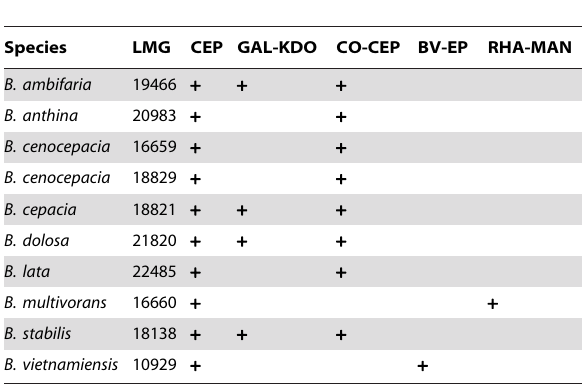
Table 5. Summary of the different EPOLs produced by each bacterial species when grown on YEM solid